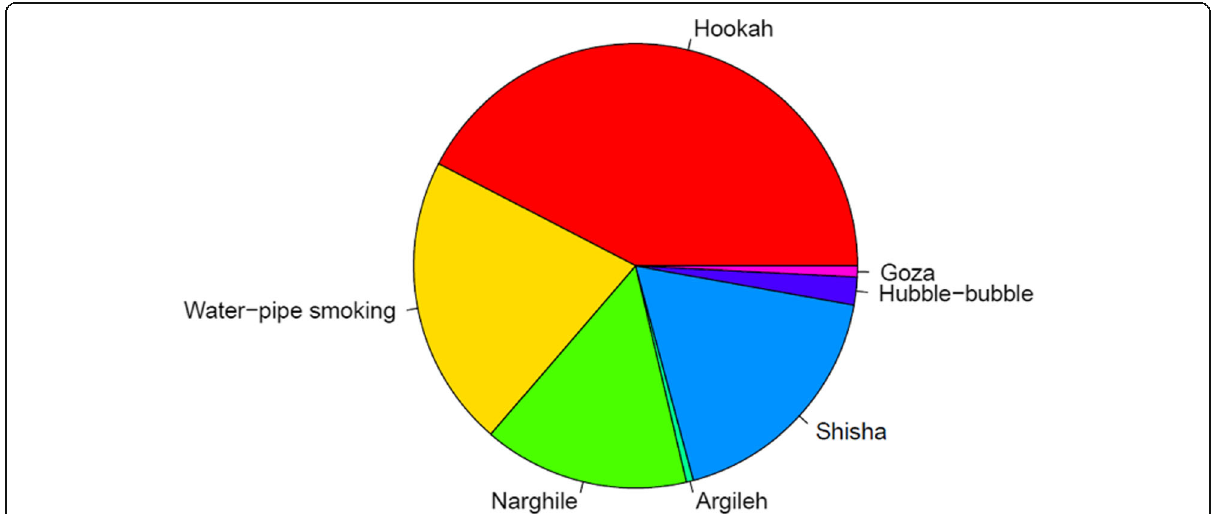
Fig. 1 PubMed search results for different names of hookah used in the literatures. Hookah is the most common used term followed by waterpipe and shisha